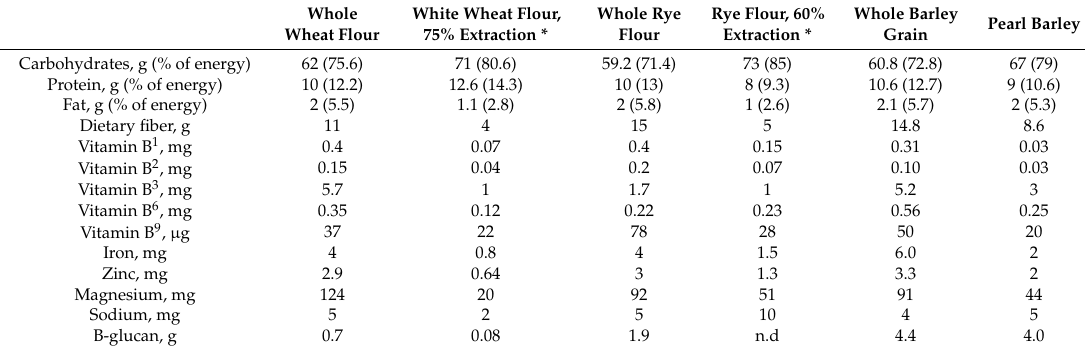
Table 1. Nutritional profile of whole grains vs. refined grains (adapted from Reference [39]).